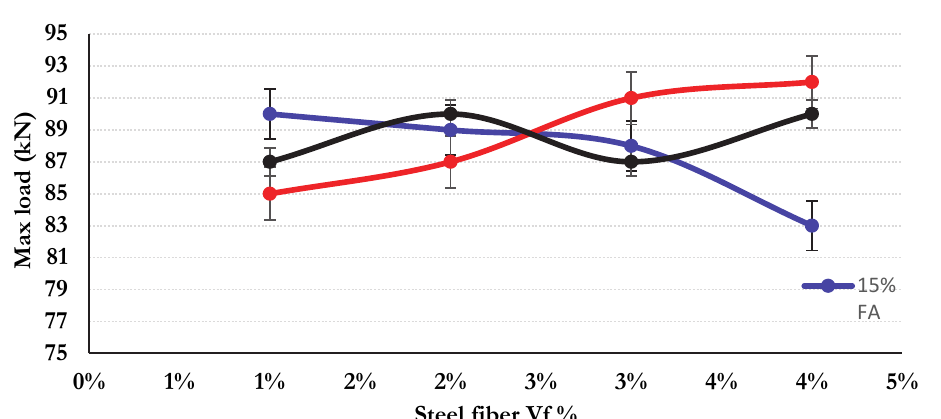
Figure 5: The effect of steel fiber volume fraction and fly ash on the maximum load.